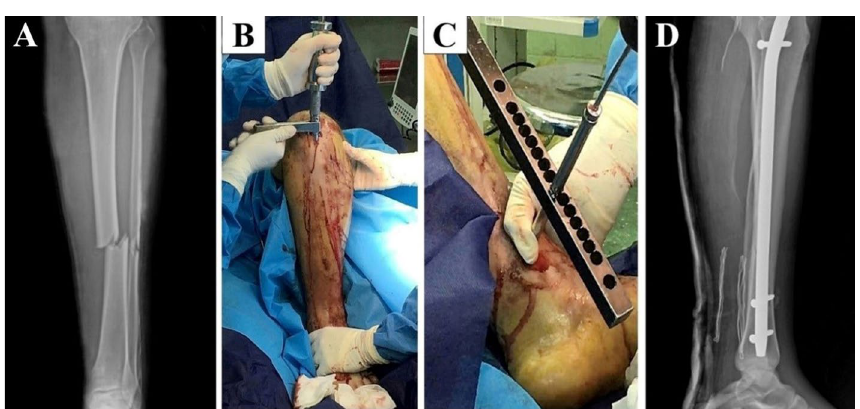
Figure 6 . Interlocking of the intramedullary nail by the TAD, ( A ) an X-ray image of the patient’s left foot before the surgery, ( B ) Inserting the IMN inside the tibia bone using the hammer, ( C ) Distal interlocking of the IMN by the TAD, ( D ) The X-ray image of the patient’s left foot one day after